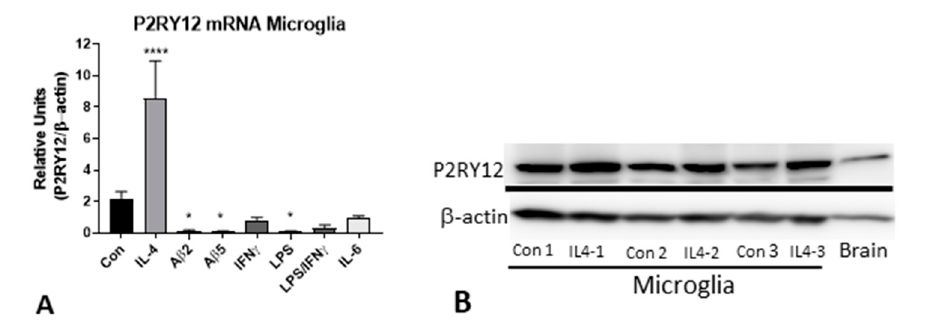
Figure 11. Expression of P2RY12 mRNA and protein by in vitro cultures of human microglia. ( A ). Interleukin-4 stimulates P2RY12 mRNA expression. Bar chart showing results real time PCR analysis for P2RY12 mRNA of human microglia stimulated with indicated agents. Results of analysis of single human microglia case (each in triplicate) and representative of other analyses. Abbreviations: Con, control unstimulated: IL-4, interleukin-4 (40 ng / mL): A β 2 and A β 5 (A β (1–42) 2 µ M and 5 µ M): IFN γ , interferon- γ (100 ng / mL): LPS, lipopolysaccharide (100 ng / mL): LPS / IFN γ (doses combined): IL-6, interleukin-6 (40 ng / mL). **** p < 0.0001. * p < 0.05. ( B ). Western blot of human microglia protein samples probed with antibody to P2RY12. Increased amounts of P2RY12 (58 kDa) in IL-4 treated samples.